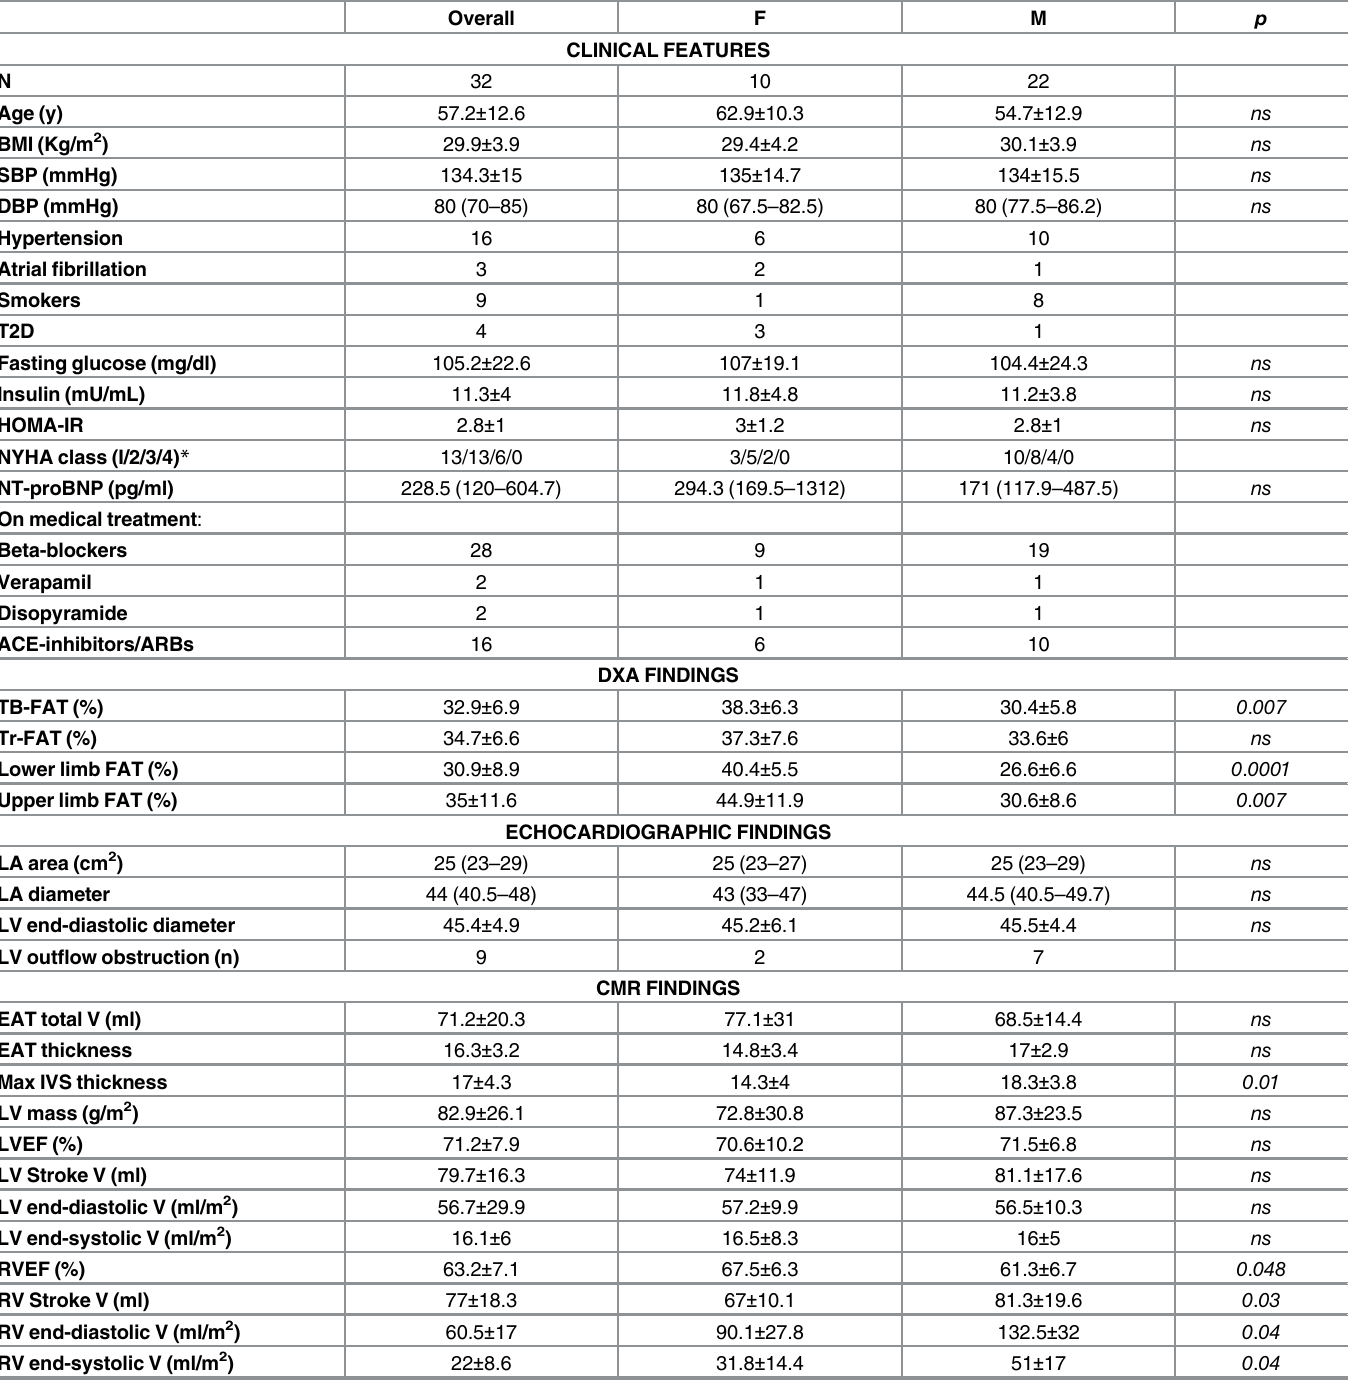
Table 1. Gender-stratified characteristics of the study